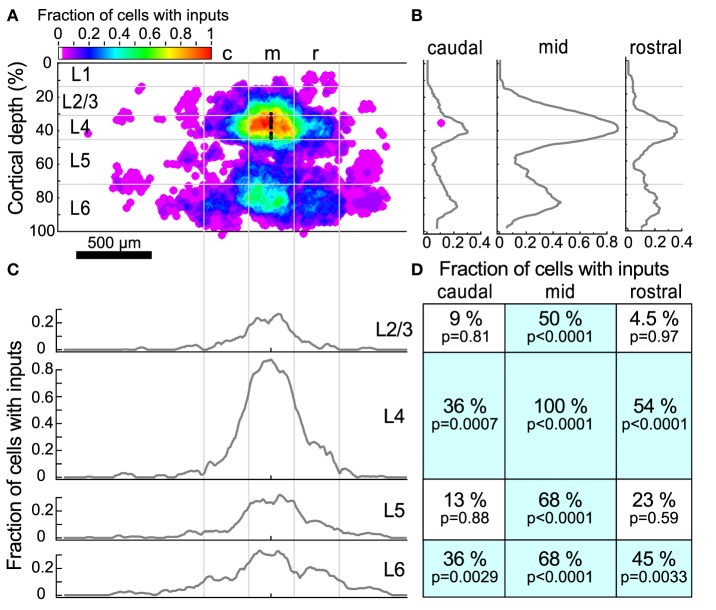
Input maps combined across all L4 cells. (A) The fraction of cells (n = 22) that had statistically probable inputs from each location. Locations were normalized onto a standardized grid as described in Materials and Methods. The map was divided into 300 μm wide columns, with the middle column centered on the recorded cell. Black dots indicate the location of patched cells. (B) The average fraction of cells with probable inputs across each column. Note the peaks in L4 and L6. (C) The average fraction of cells with probable inputs across each layer. Note the slight dips in connection probability between columns. (D) The fraction of cells that had a statistically probable input area larger than 104 um2 (approximately 9 adjacent sites) within each section. p-values indicate the probability that the observed frequency of inputs from a given area differs from that expected from a uniform distribution of inputs (see text).